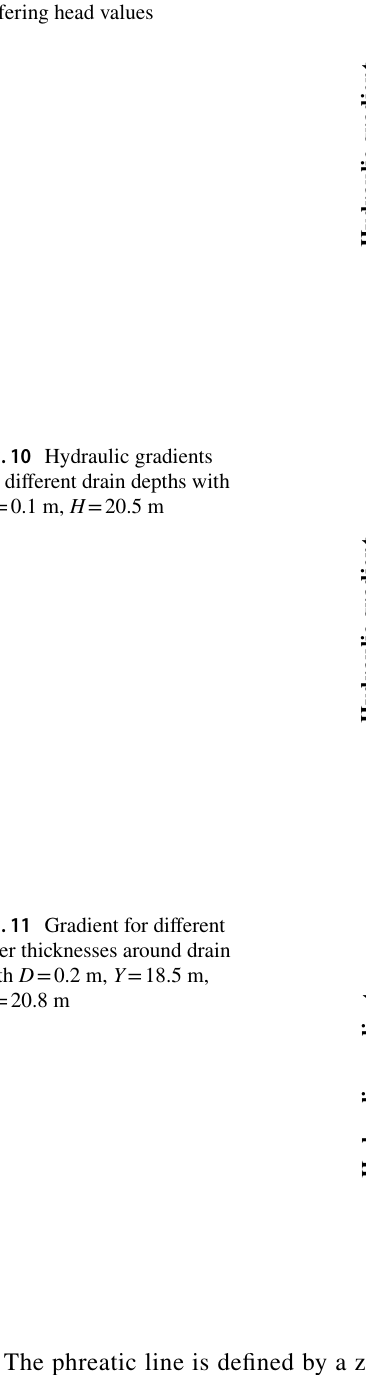
Fig. 9 Hydraulic gradients for differing head values